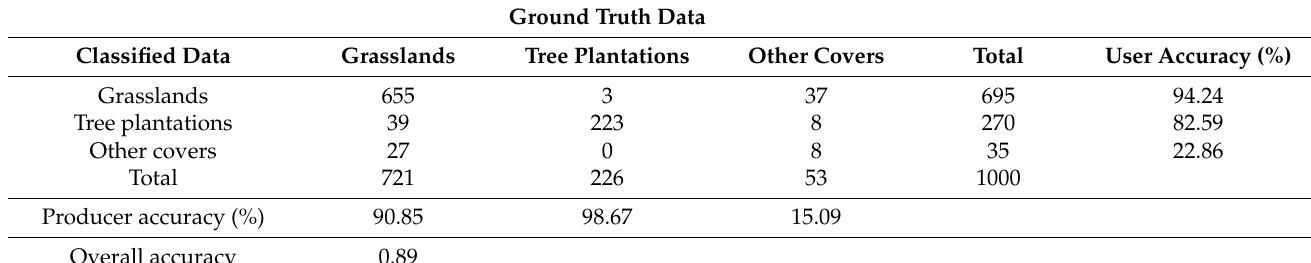
Table A17. Error matrix for the unsupervised classification for the period 2014–2015 based on 1000 random points distributed across the Aguapey VGA. The diagonal contains correctly classified pixels.